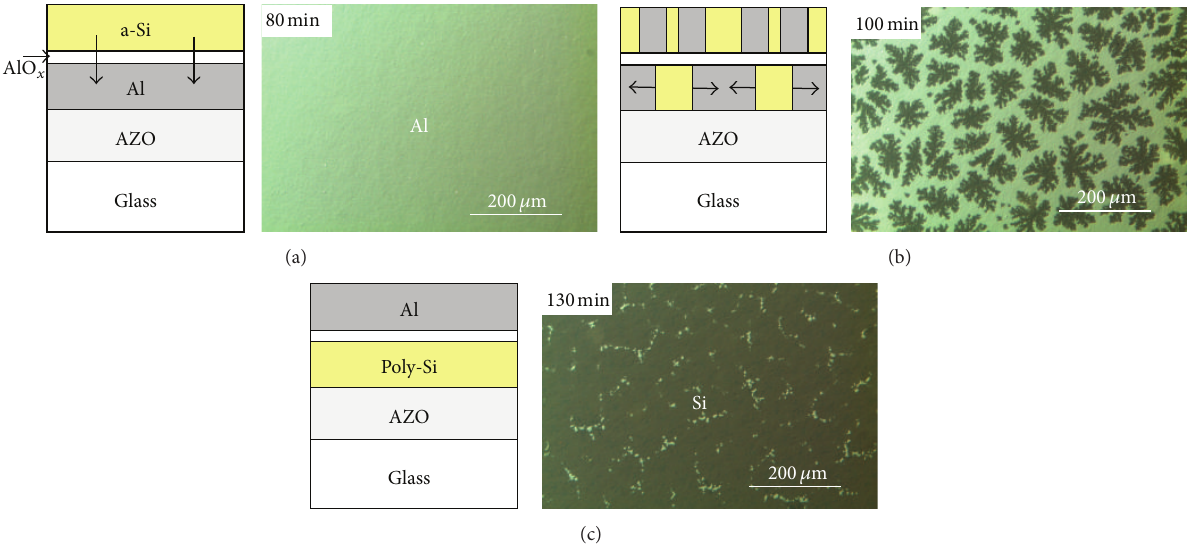
Figure 1: Schematic cross-sections and optical micrographs for a sample with an AZO underlayer, annealed at 500 ∘ C for (a) 80 min, (b) 100min, and (c) 130 min. Each diagram corresponds to its respective optical micrograph showing the back surface of the sample through the transparent AZO and